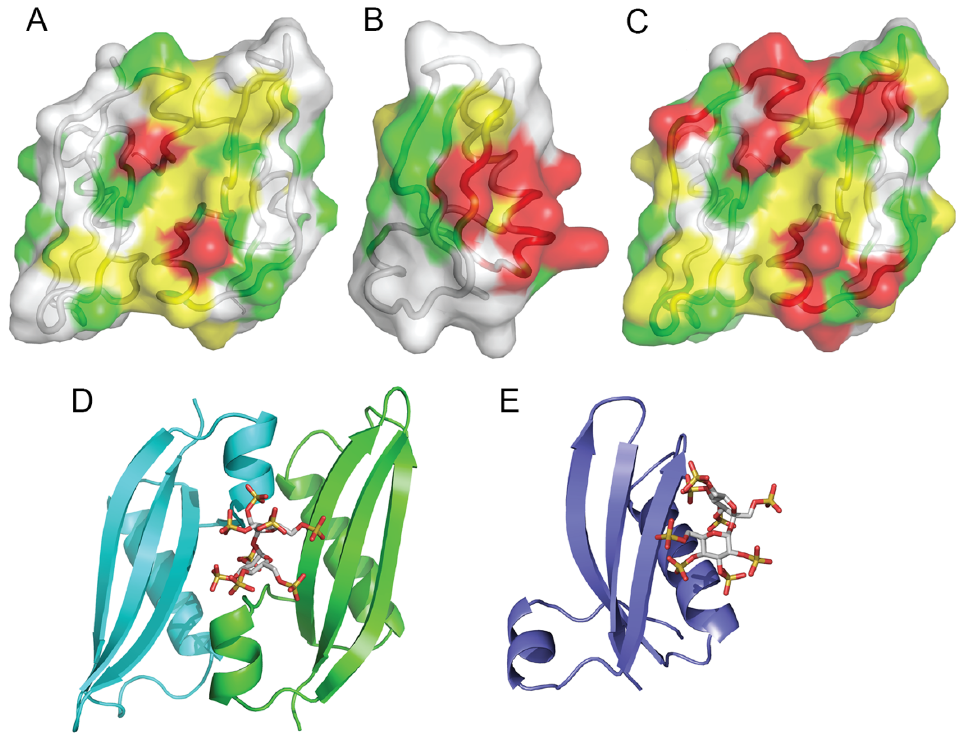
Figure 5. Ligand binding sites predicted by coarse-grained simulations. Predicted sucrose octasulfate interactions with ( A ) SrfN and with ( B ) SssB-III, and ( C ) predicted maltohexaose dodecasulfate interactions with SrfN. Red, yellow, and green indicate binding score levels of . 0.1, . 0.05, and . 0.02, respectively. D and E : Low energy structures of models shown in panels A and B after being reverse-mapped to atomistic sucrose octasulfate in the space occupied by the coarse-grained equivalent, followed by 1000 steps of vacuum minimization in GROMACS [73] using the CHARMM force field to eliminate clashes, with ligand parameters were derived using SwissParam [74]. The all-atom models are shown for illustrative purposes and do not necessarily indicate global free energy minima at all-atom